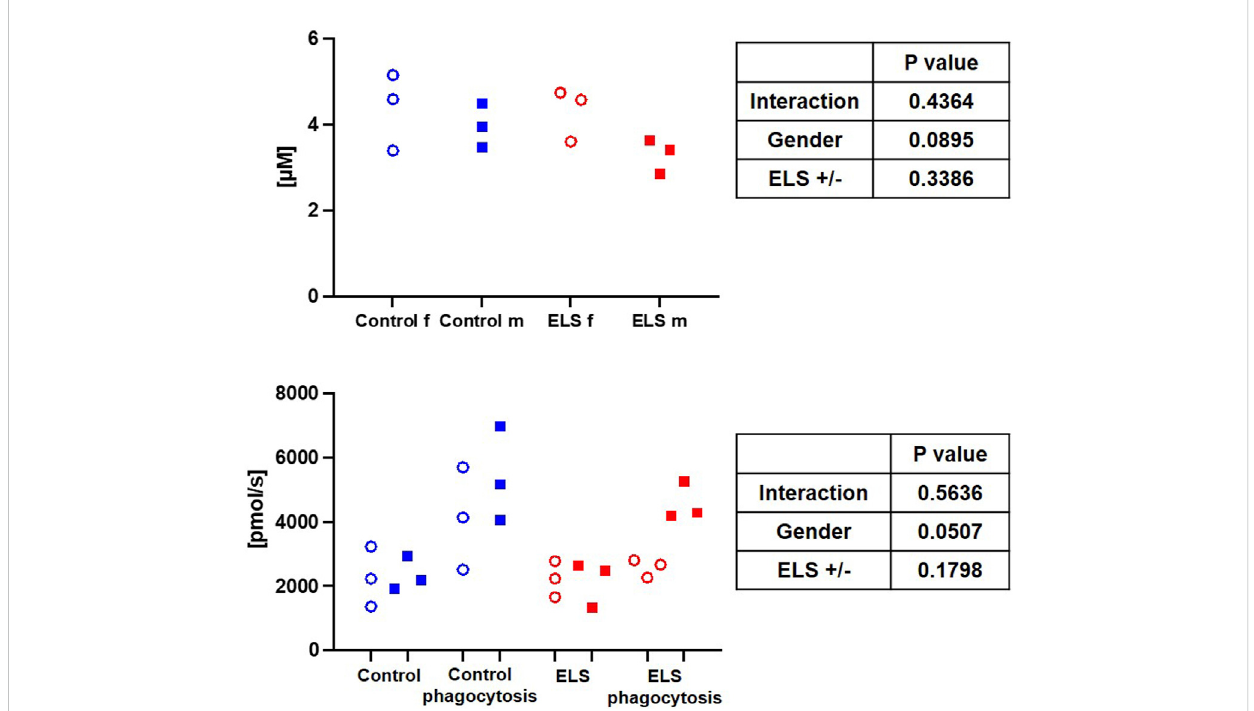
FIGURE 4 (cid:129) (cid:1) Whole blood superoxide anion (O 2 ) concentration in the control (blue symbols) and Early Life Stress (ELS; red symbols) groups separated for male ( “ m ” , solid squares) and female ( “ f ” , open circles) swine (upper panel). Granulocyte superoxide anion (O 2 phagocytosis with E. coli in control (blue symbols) and Early Life Stress (ELS; red symbols) animals separated for male (solid symboles) and female (open symboles) swine (lower panel). Each symbol refers to samples from an individual animal. Note that O 2 samples from male swine irrespective of the presence/absence of ELS, while this response was abolished in female animals with